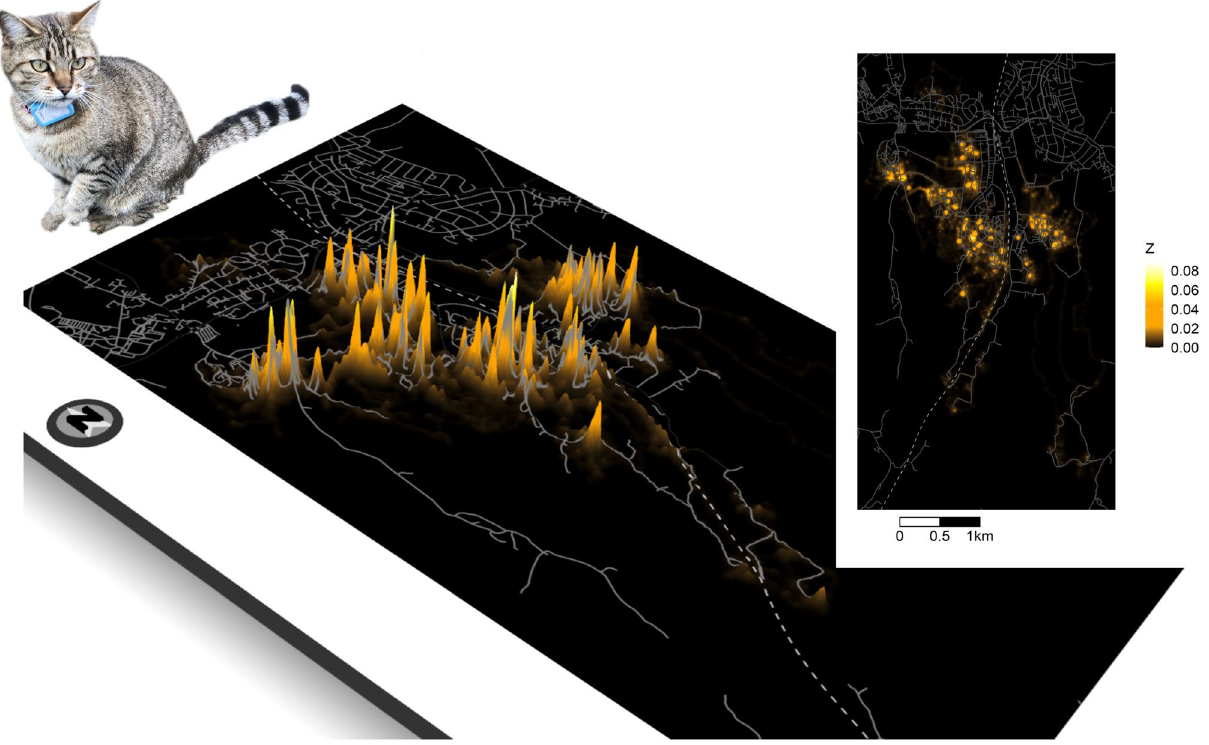
Figure 3. Three-dimensional representation of the catscape (with 2D inset), constructed using individual utilization distributions of 92 domestic cats. The height of the surface ( Z , square root transformed for visualization) denotes the intensity of use by cats. Grey lines indicate roads; a fenced railroad (dashed line) transects the study area. Both maps were created using R 17 ; cat photo by R.